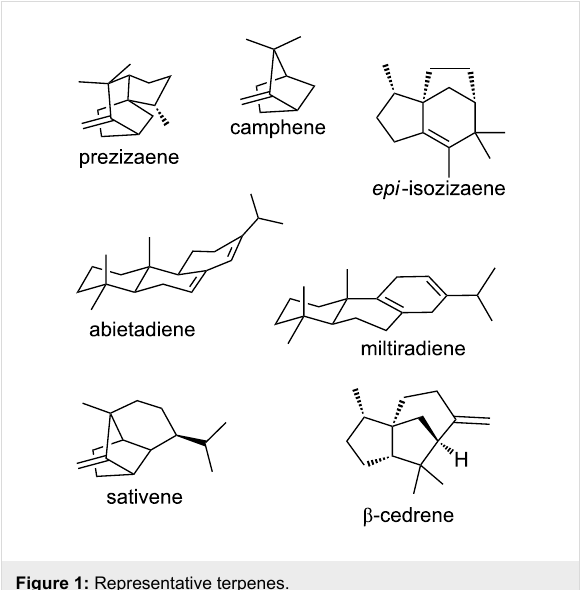
Figure 1: Representative